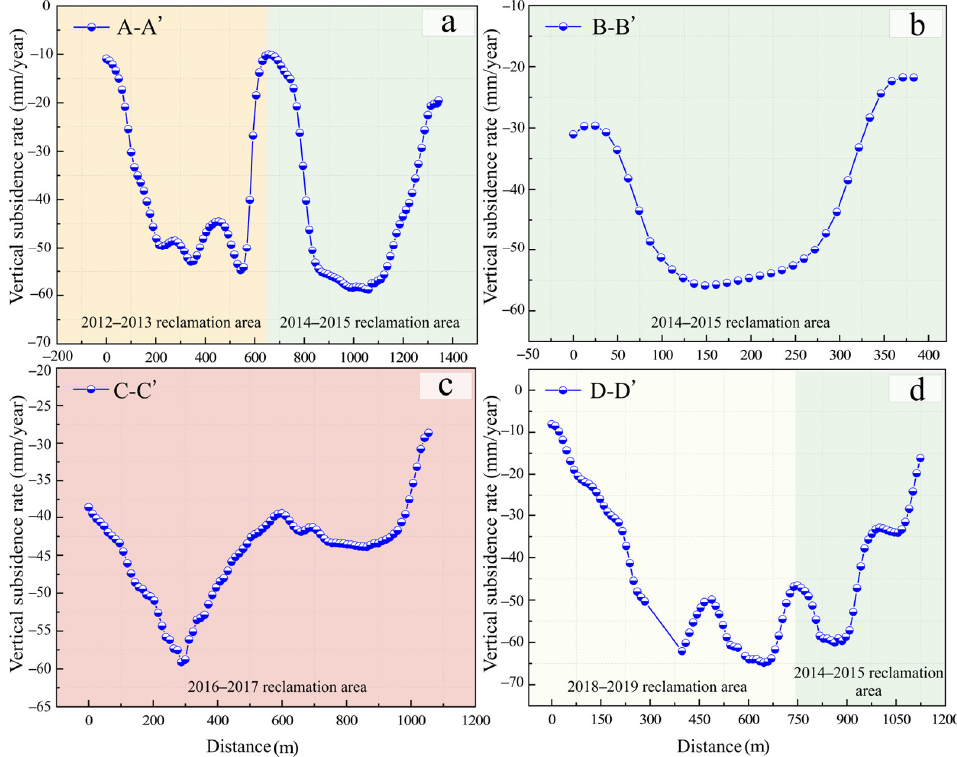
Figure 9. Vertical subsidence rate profiles (the location of the profile are marked in Figure 6). ( a − d ) profiles along AA’, BB’,CC’, DD’, respectively The areas with vertical subsidence rates greater than −100 mm/year at DJBIA are lo- cated in the corner locations at the airport with the edge locations, which is in the recla- mation areas completed in 2018–2019 and 2020–2021. The reclamation of the middle area of the airport was completed in 2012–2013 and 2014–2015, and its vertical subsidence rate was smaller but reached −70 mm/year to −80 mm/year. Overall, the vertical subsidence rate exhibits an emission-like progression from the middle to the edge regions. There is a certain pattern of vertical subsidence rate in the areas where reclamation was completed at different periods. From Figure 10, it can be seen that the maximum, minimum, and median values of vertical subsidence rate are in different reclamation periods. The red points indicate the average vertical subsidence rate. The InSAR subsidence monitoring points in Figure 10 mean that the subsidence rate on the InSAR high-coherence points in Figure 6 shown by counting the magnitude of the rate, and the arcs next to the subsidence points represent the normal distribution curves of these points. The data of this figure are